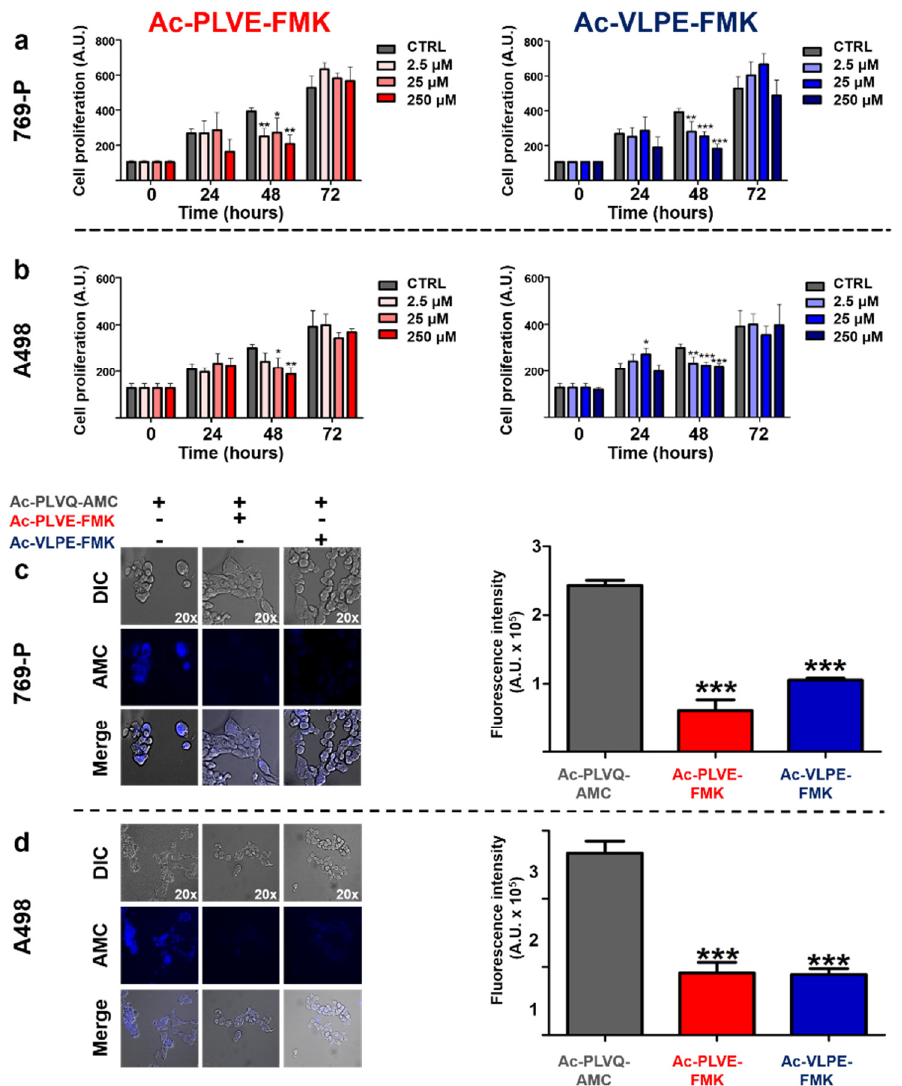
Figure 3. The effect of the peptide inhibitors on human 769-P and A498 renal cancer cell proliferation and proteolytic activity. ( a ) 769-P and ( b ) A498 cells were treated with increasing doses of Ac-PLVE-FMK (red bars) and Ac-VLPE-FMK (blue bars) (2.5–250 μM). Cell proliferation was measured after 24, 48, and 72 h via MTT (3-(4,5-dimethylthiazol-2-yl)-2,5-diphenyltetrazolium bromide) assay. Data represent the mean (±S.D.) of at least three independent experiments, each performed in triplicate. ( c ) Fluorescence microscopy evaluation and quantification of the cell proteolytic activity in 769-P and ( d ) A498 cells towards the fluorogenic substrate Ac-PLVQ-AMC in the absence or presence of Ac-PLVE- FMK and Ac-VLPE-FMK. The cells were seeded in a 96- well plate and after exposure to the peptides for 30 min prior incubation with the fluorescent substrate Ac-PLVQ-AMC for 10 min. Data are expressed as mean (±S.D.), and significance was calculated through one-way ANOVA followed by Dunnet’s test. * = p < 0.05, ** = p < 0.01, *** = p < 0.001.